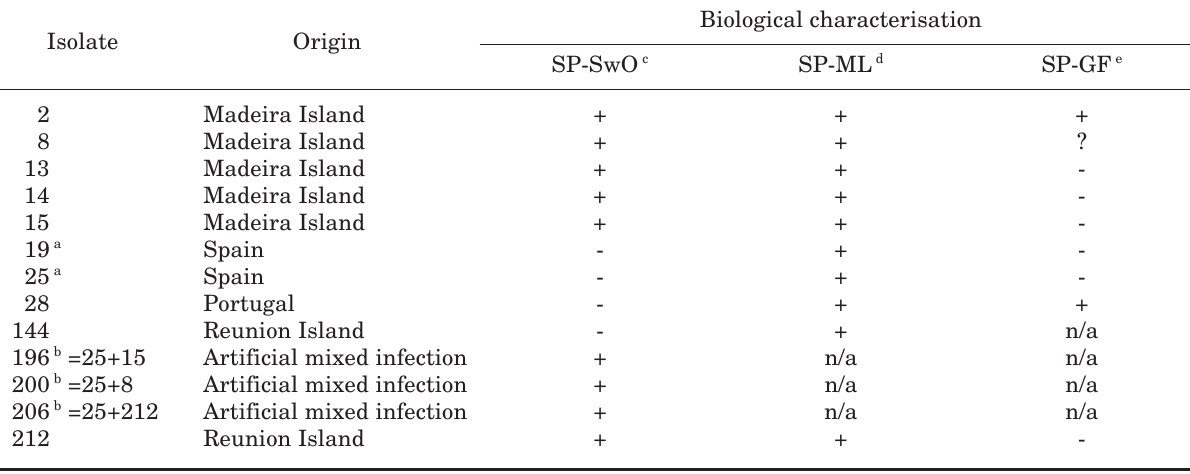
Table 1. Characterisation of the 12 Citrus tristeza virus isolates (Bonacalza,